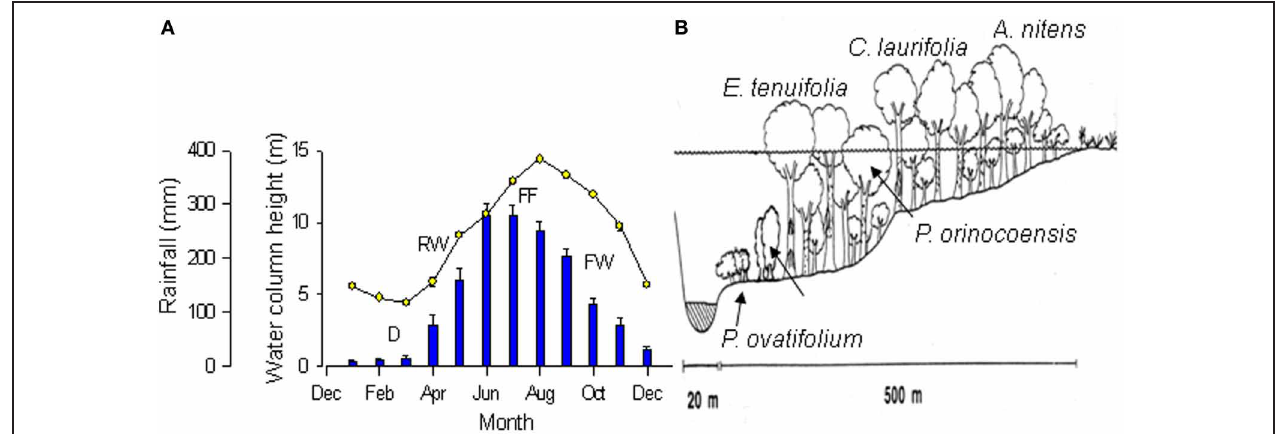
FIGURE 1 | (A) Changes over the year in rainfall (bars) and water column height (circles) of the Mapire River relative to the Orinoco. Values are mean ± SE ( n = 4 years). Stages of the flooding cycle are indicated as drainage (D), rising-waters (RW), full flooding (FF), and falling-waters